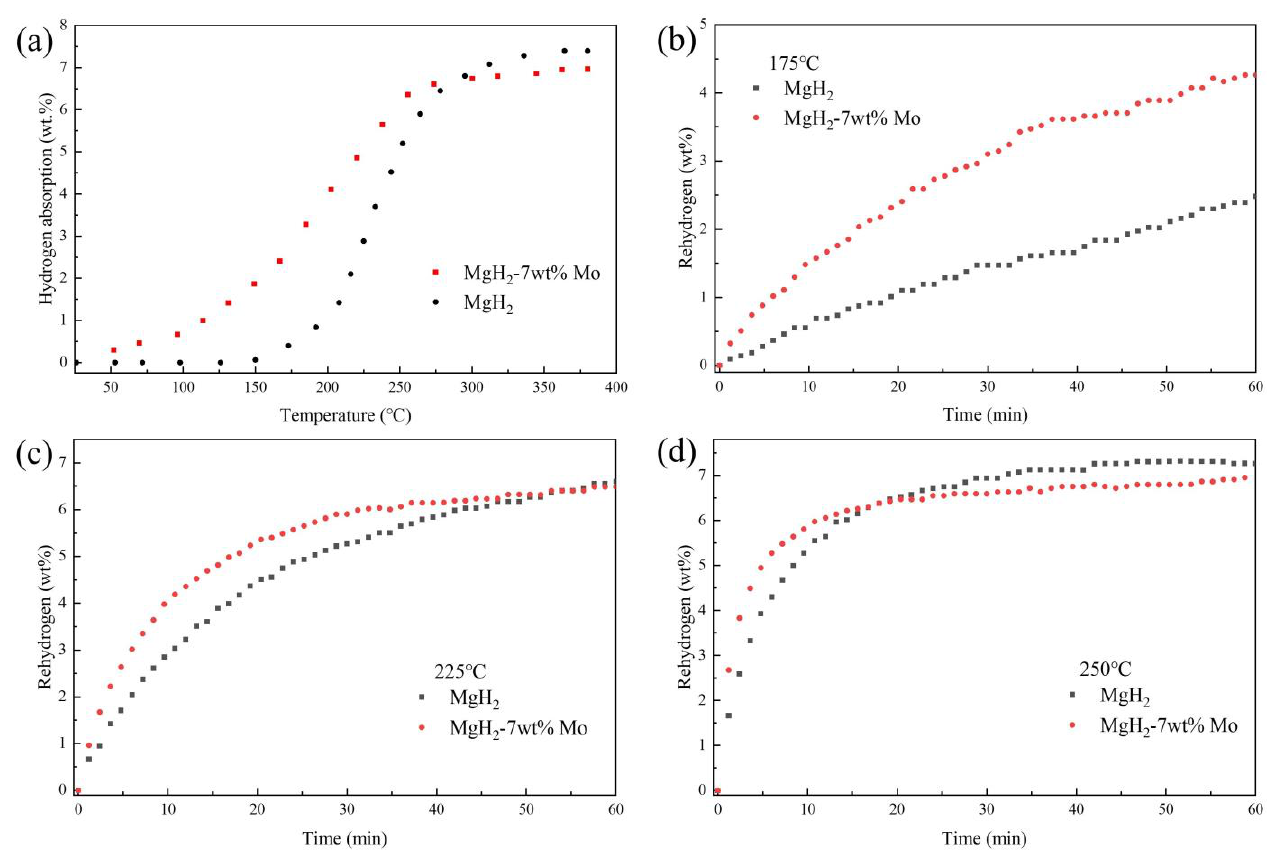
Figure 3. ( a ) Non-isothermal hydrogen absorption curves of MgH 2 and MgH 2 -7wt%Mo; comparison of isothermal hydrogenation curves of MgH 2 -7wt%Mo and MgH 2 at ( b ) 175 °C, ( c ) 225 °C, and ( d ) 250 °C.